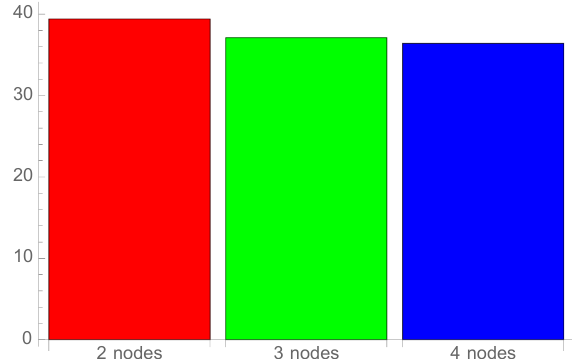
Figure 7. Total number of infectious devices with different values of γ 1